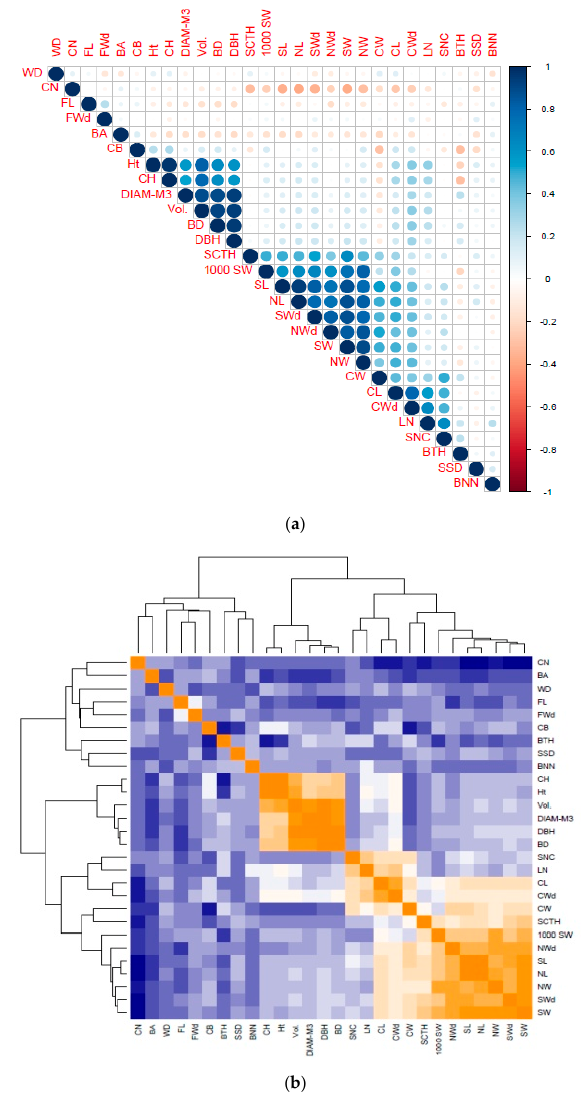
Figure 2. Correlation analysis of 28 growth, wood, cone, seed, and nut traits of 110 P. koraiensis clones grown at the Naozhi orchard. ( a ) Significance of correlation levels between traits and ( b ) clustering dendrogram of the correlated traits. WD: wood density; CN: cone number; FL: fiber length; FWd: fiber width; BA: branch angle; CB: crown breadth; Ht: tree height; CH: crown height; DIAM-M3: diameter at 3-m height; BD: basal diameter; DBH: diameter at breast height; SCTH: coat thickness; 1000 SW:1000 seed weight; CW: cone weight; SL:seed length; NL: nut length; SWd: seed width; NWd: nut width; NW: nut weight; SW: seed weight; CW: cone weight; CL: cone length; CWd: cone width; LN: layer number; SNC: seed number per cone; BTH: bark thickness; SSD: stem straightness degree; BNN: branch number per